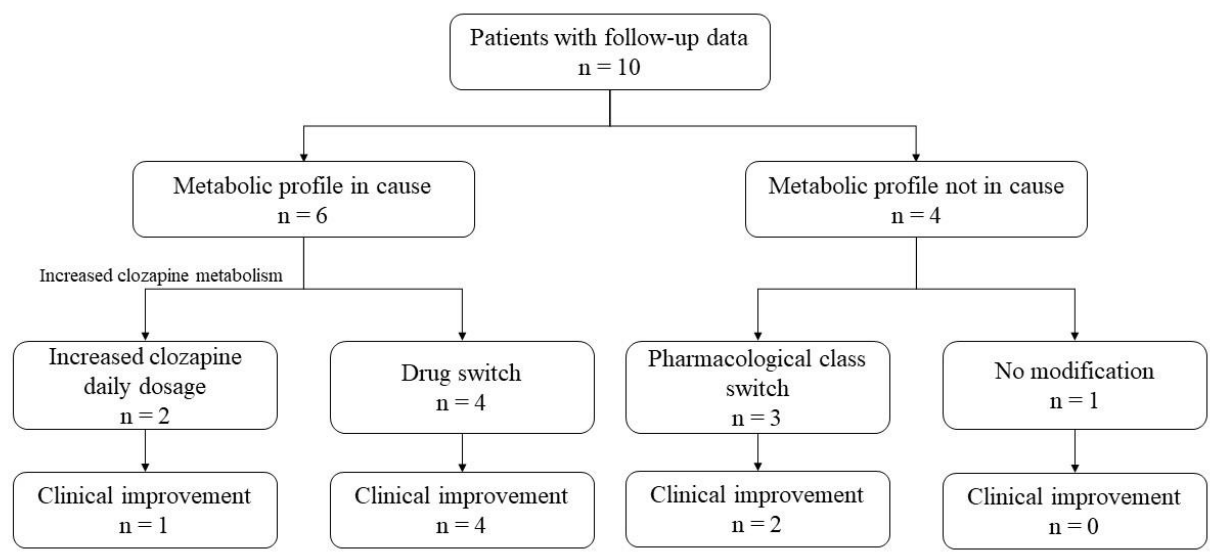
Figure 3. Therapeutic decision and clinical consequences following phenotyping.